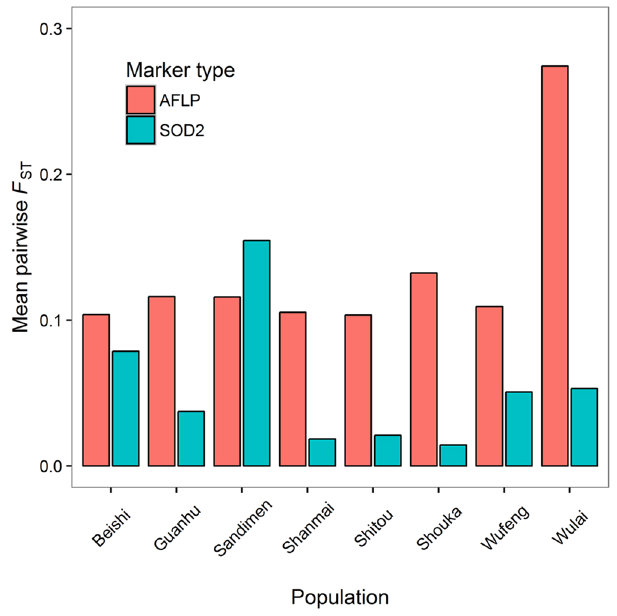
Figure 3. Degree of Mean pairwise F ST values of each population in comparison with those of the remaining populations based on the second intron sequences of Cu/Zn SOD 2 and amplified fragment length polymorphic